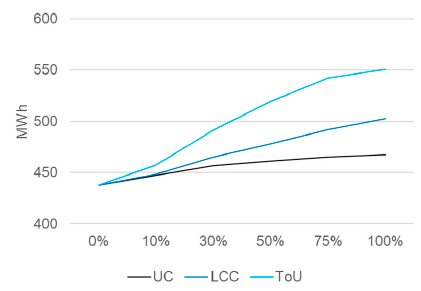
Figure 14. Development of the building’s minimum demand.